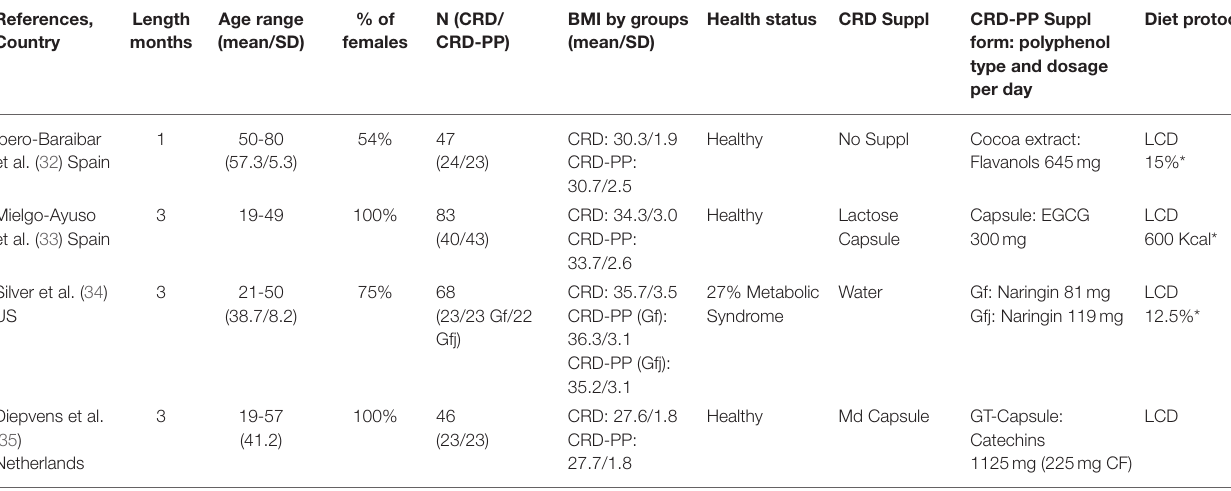
TABLE 1 | Characteristics of the studies that combined calorie restricted diets with polyphenols. References,